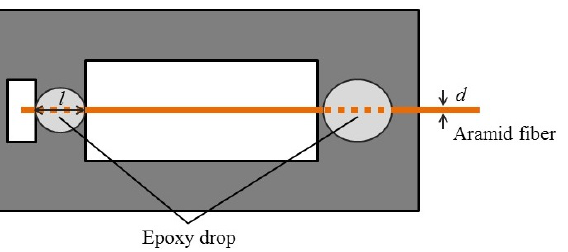
Figure 2: Schematic of the single fiber pull-out test